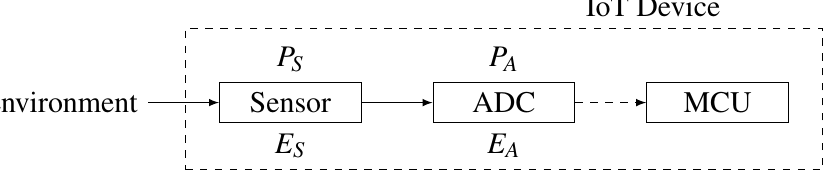
and P represent S A and E represent the error S A